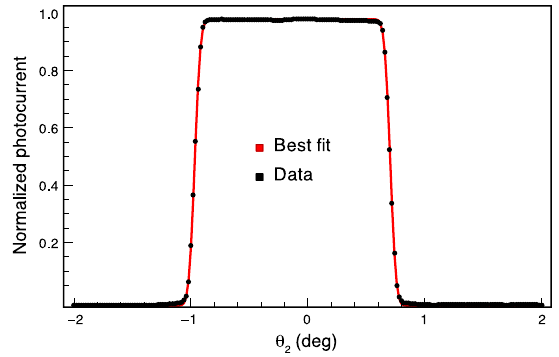
FIG. 16. Scan of normalized detector response vs θ 2 with no sample, using a 180 eV photon beam. The red curve is the best fit, using Eq. (18).